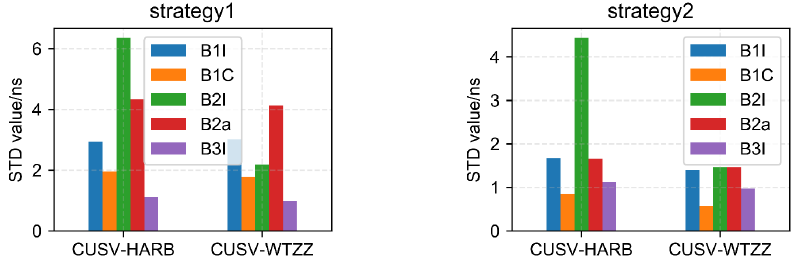
Figure 12. The time sequence diagram of two time links, two strategies, and five frequency points. Taking the ionosphere-free dual-frequency results of B1I and B3I as a reference, the single-frequency results of five frequencies were calculated by difference with each other to obtain the STD in Figure 13.